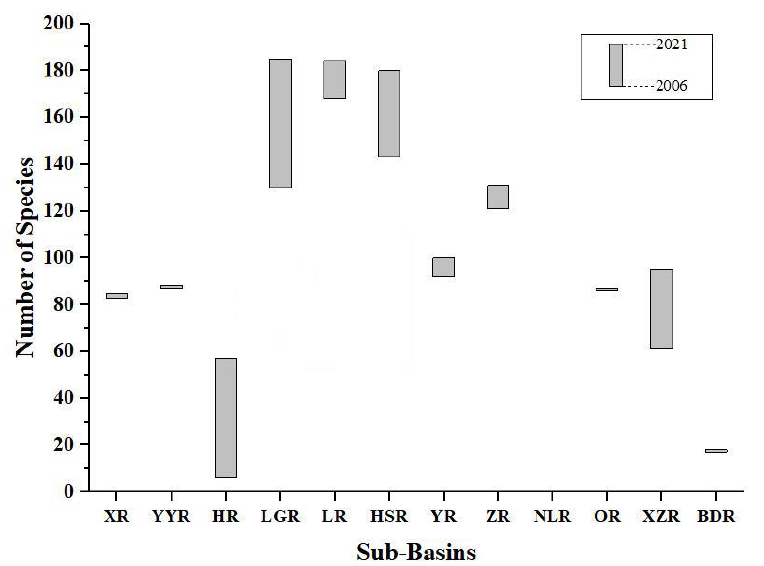
Figure 2. Comparison of fish species numbers in 2006 and 2021. Sub−basin codes are described in Table 1.